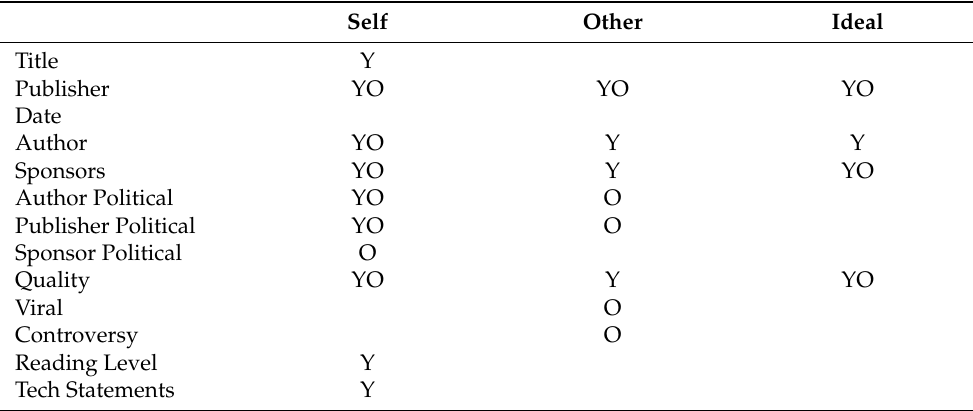
Table 4. Metrics with over 50% indicating a lot or a great deal, by age group. ‘Y’ indicates the younger group (18 to 29) and ‘O’ indicates the older group (30 and above). Self